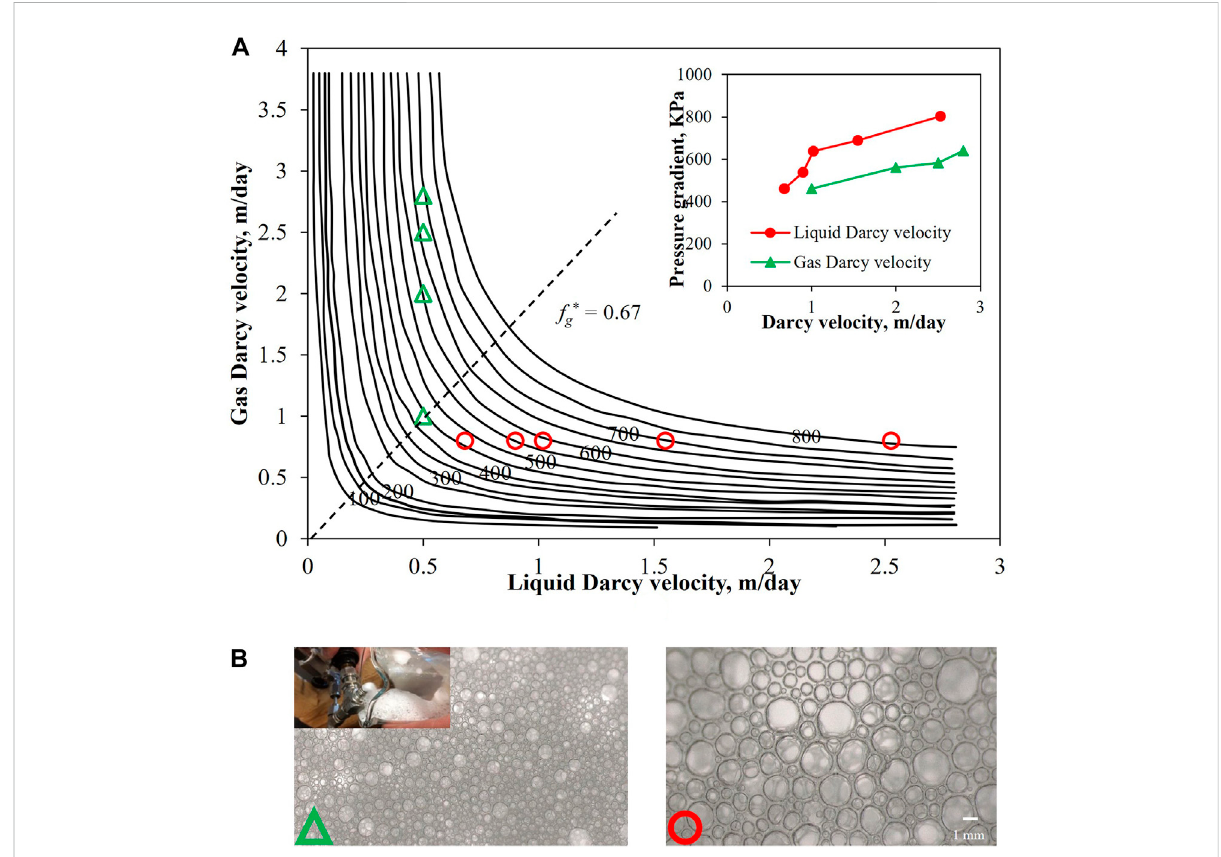
FIGURE 2 (A) Predicted (solid line) and measured (dots) steady-state pressure gradient as a function of gas and liquid Darcy velocities in the core with the permeabilityof55 mD.Reddotsaremeasuredbyvaryingtheliquidvelocityfrom0.68to2.52 m/dayatconstantgasvelocityof0.8 m/day,andgreen dots are measured by varying the gas velocity from 1.0 to 1.75 m/day at constant liquid velocity of 0.5 m/day. (B) Optical micrographs of foam collected at the outlet of core at gas and liquid velocity of 0.5 and 2.5 m/day (left), 1.0 and 0.8 m/day (right),